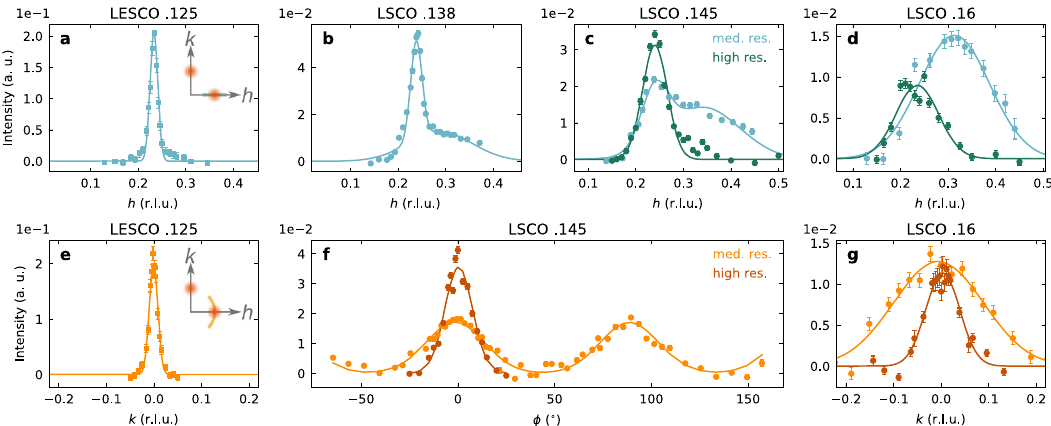
Fig. 2 Doping evolution of the charge order in LSCO and LESCO at base temperature. a – d Longitudinal scans along ( h , 0) for the compounds and compositions as indicated. e , g Transverse scans through the longitudinal peak position ( δ , k ) for doping concentrations as indicated. f Circular arc scan through two charge order re fl ections, with ϕ = 0 at ( h , 0). Panels for LSCO x = 0.145 and 0.16 compare high- and medium- resolution data. Solid lines are Gaussian fi ts. Error bars are set by counting statistics. See text for further explanations. Insets display sketches of the charge order re fl ections in reciprocal space and the scan trajectories. Data in a , e are adapted from ref. 27